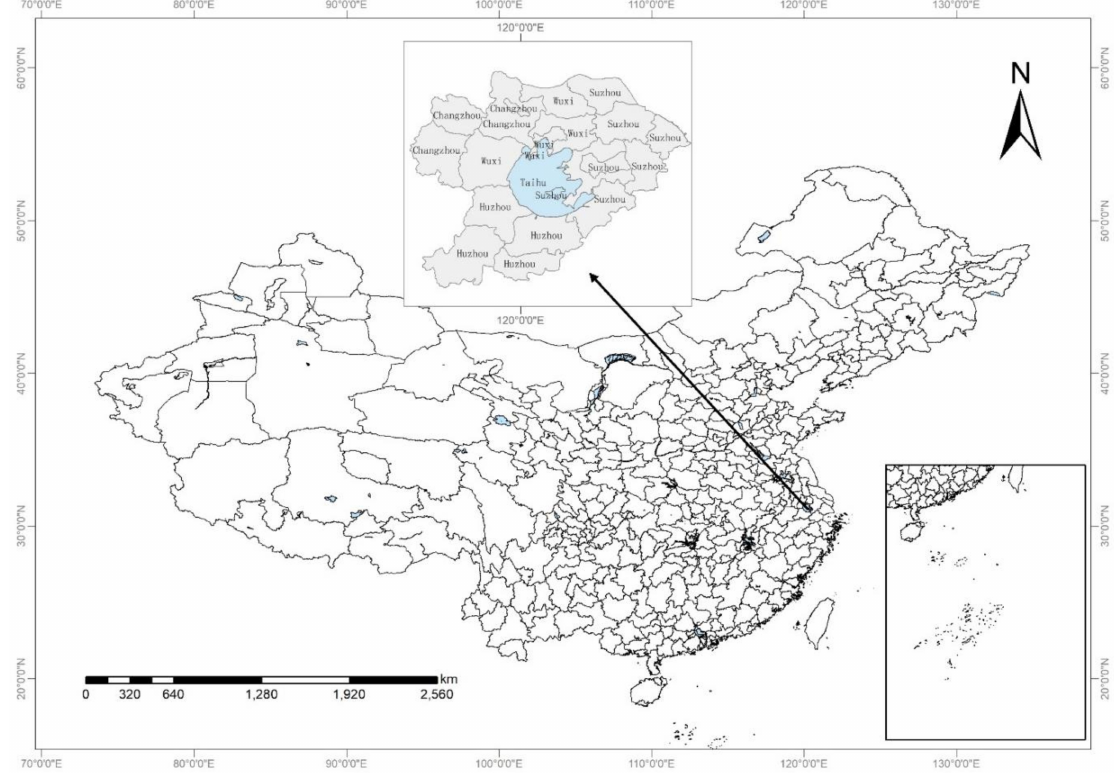
Figure 1. Map of Taihu Lake (Between 30 ◦ 55 (cid:48) 40 (cid:48)(cid:48) –31 ◦ 32 (cid:48) 58 (cid:48)(cid:48) N and 119 ◦ 52 (cid:48) 32 (cid:48)(cid:48) –120 ◦ 36 (cid:48) 10 (cid:48)(cid:48) E) in